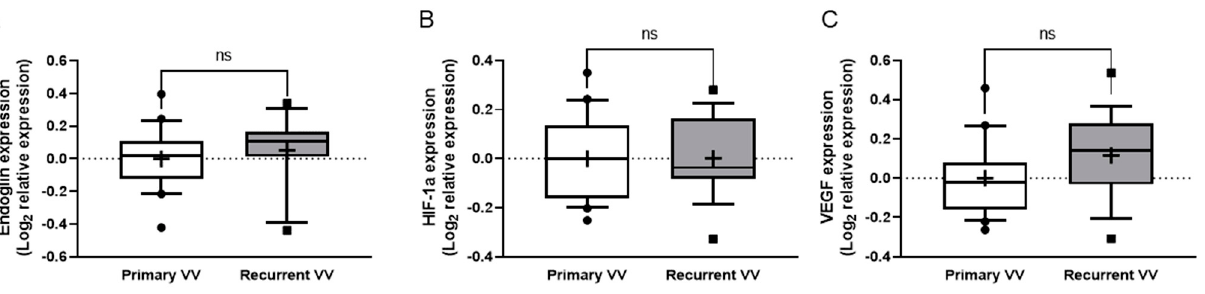
Figure 3. Expression of angiogenesis-related genes in distal samples. ( A – C ) Quantitative analysis of expression of the genes investigated in samples of the distal great saphenous vein or other vein—according to groups—(tissue obtained during surgery) was performed by quantitative RT-PCR. Relative expression of Eng, endoglin ( A ), HIF1A: hypoxia-inducible factor 1A ( B ) and VEGFA: vascular endothelial growth factor A ( C ) in recurrent varicose vein vs primary varicose vein were analysed. For data normalisation, qPCR analyses are represented as logarithmic transformation of the relative expression; box plots show median and 25–75 percentiles, and whiskers show 10–90 percentile. ns: Not significant.